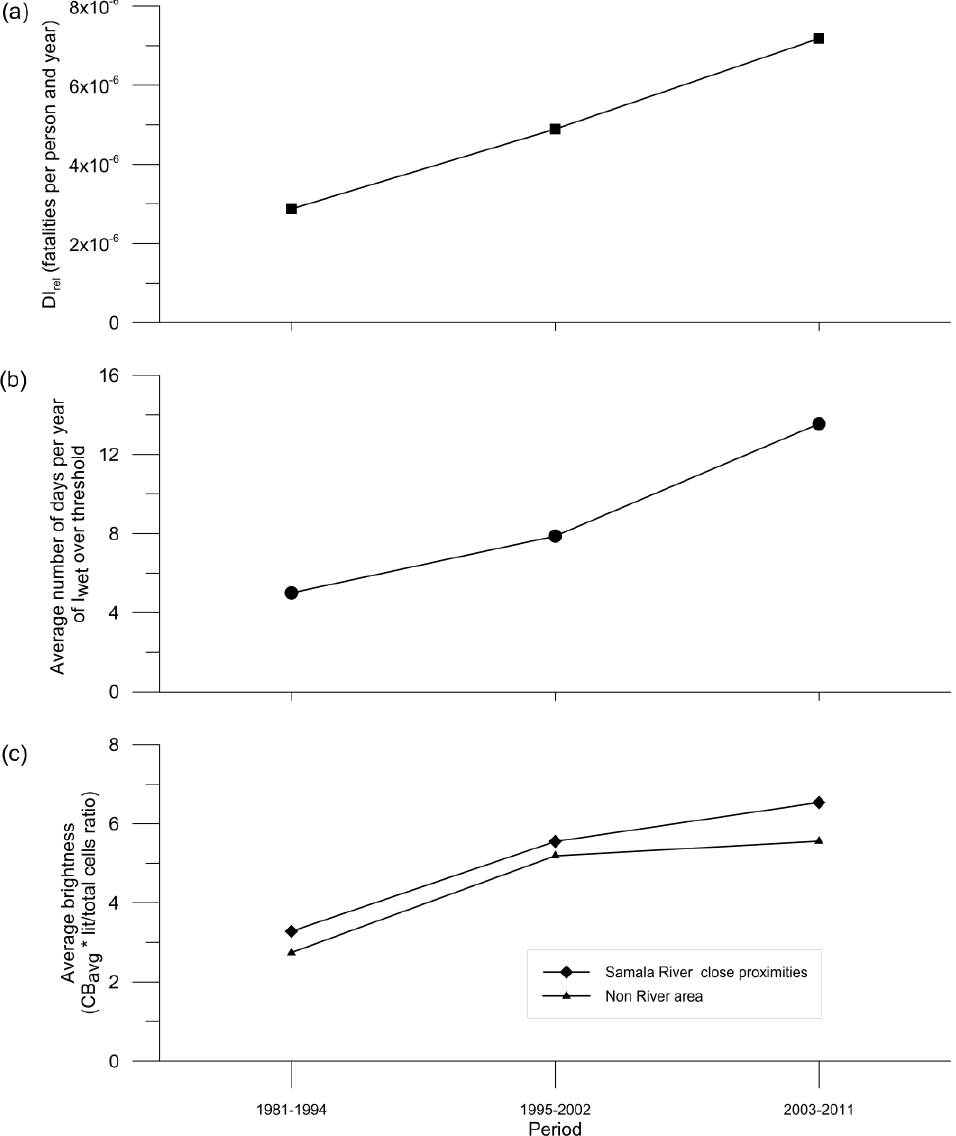
Figure 7. Changes in the Samala River catchment regarding ( a ) relative disaster impact DI rel associated with hydrometeorological causes (a proxy for disaster risk), ( b ) average number of days in the year of I wet over the identified threshold ([32] (a proxy for natural hazards), and ( c ) average brightness (a proxy for vulnerability in terms of exposure). Average brightness (c) corresponds to the values of the final year of each period (1994, 2002, and 2011) and is shown separately for the close proximities of the river and the rest of the catchment (non river